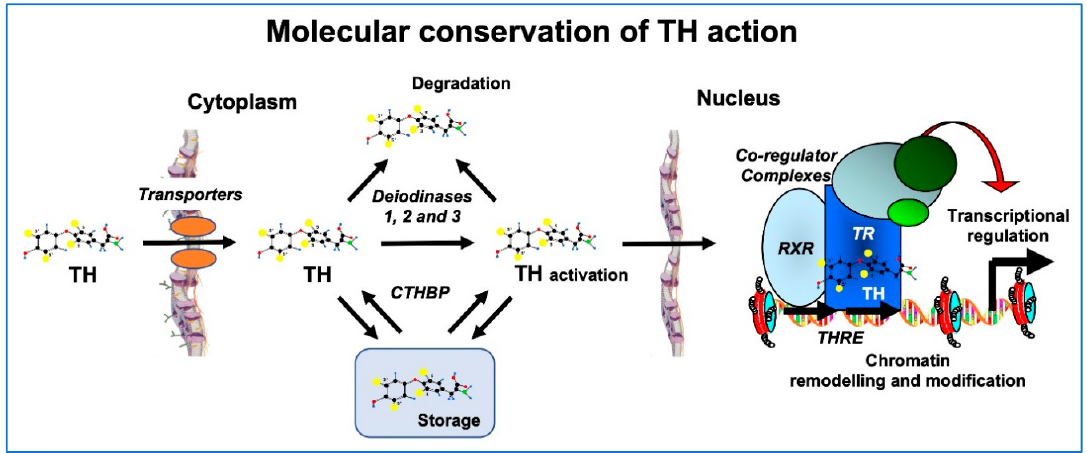
Figure 3. Conservation of TH signaling in vertebrates. Processes from TH transport into the cell to control of gene expression share homologous proteins and mechanisms in humans, fish and amphibians. Homologous TH transporters enable TH entry into cells, where deiodinases function to activate or deactivate it. Cytoplasmic TH binding proteins (CTHBPs) modulate cytoplasmic availability. In the nucleus, the TH receptor (TR) forms a heterodimer with the retinoid X receptor (RXR) and binds to DNA at TH response elements (THRE), where co-regulator complexes are recruited to alter the state of chromatin, ultimately leading to induced expression of TH response genes. Modified from [27].